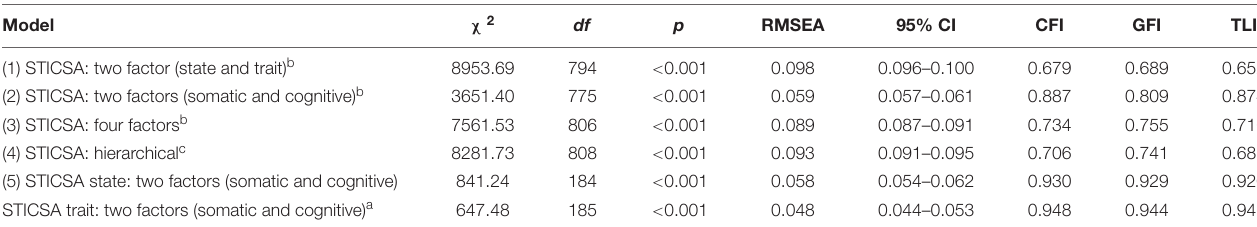
TABLE 1 | Fit indices for STICSA models.